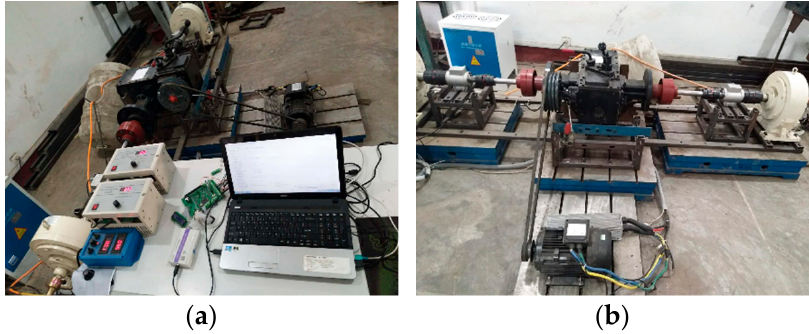
Figure 8. System test bench. ( a ) Side test bench. ( b ) Front test bench.